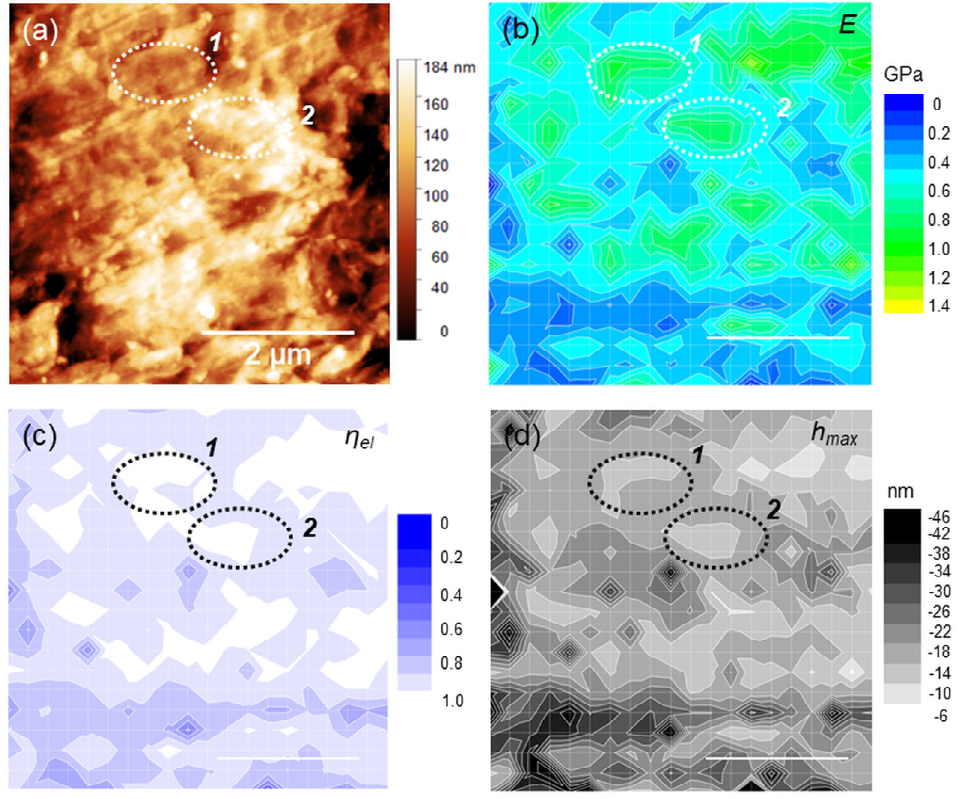
Figure 3. ( a ) 5 × 5 μ m 2 topography with indication of two features of interest (1 and 2); ( b – d ) E , η el and h max maps of the same region.